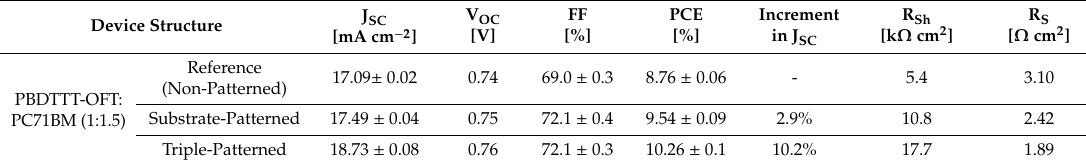
Figure 5. Device characteristics of ultrathin PSCs with/without nanogratings. ( a ) Density–voltage (J–V) curves under AM 1.5G illumination at 100 mW cm − 2 , and ( b ) external quantum efficiency (EQE) spectra of free-standing ultrathin PSCs. Table 1. Device performance of various device structures with/without the 1D nanograting patterns. The average values are calculated from five or more cells. R SH and R S are obtained from the slope of the J–V curves in the dark at 0 and 1 V, respectively.